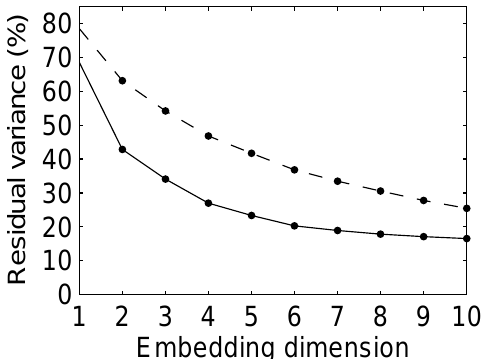
Fig. 5. Residual variance obtained from the Isomap application us- ing K = 12 (solid) and from the EOFs (dashed) of the Asian mon- soon SLP anomalies versus the embedding